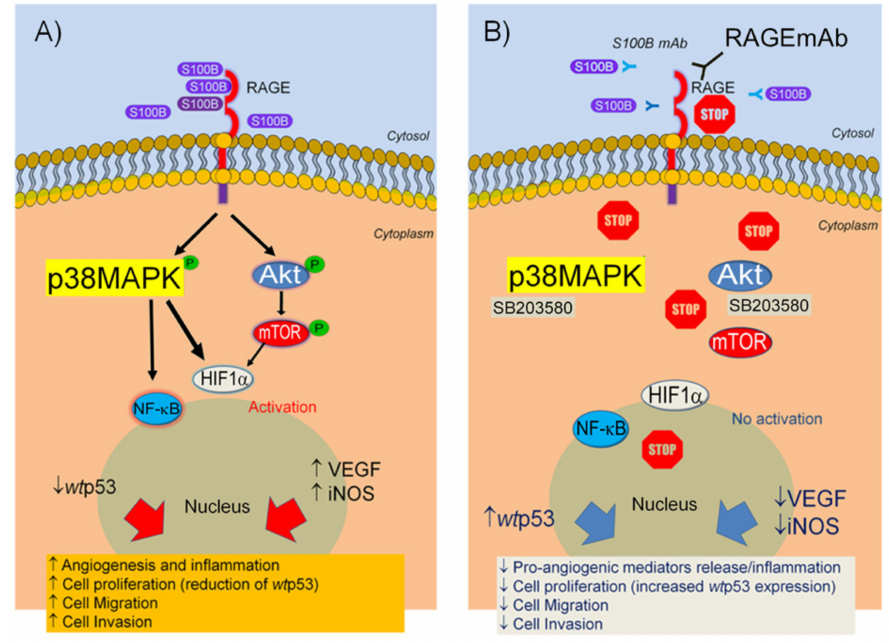
Figure 3. Representation of S100B e ff ects on Caco-2 cells. ( A ) S100B interacts at RAGE receptors and downstream activates p38 / Akt signaling pathway leading to cell proliferation, increased release of cell migration and angiogenesis. ( B ) S100B e ff ects are blocked by specific S100BmAb, as well as, RAGE specific antibody and p38 / Akt inhibitor SB203580, leading to a significant control of angiogenesis and cell invasion in